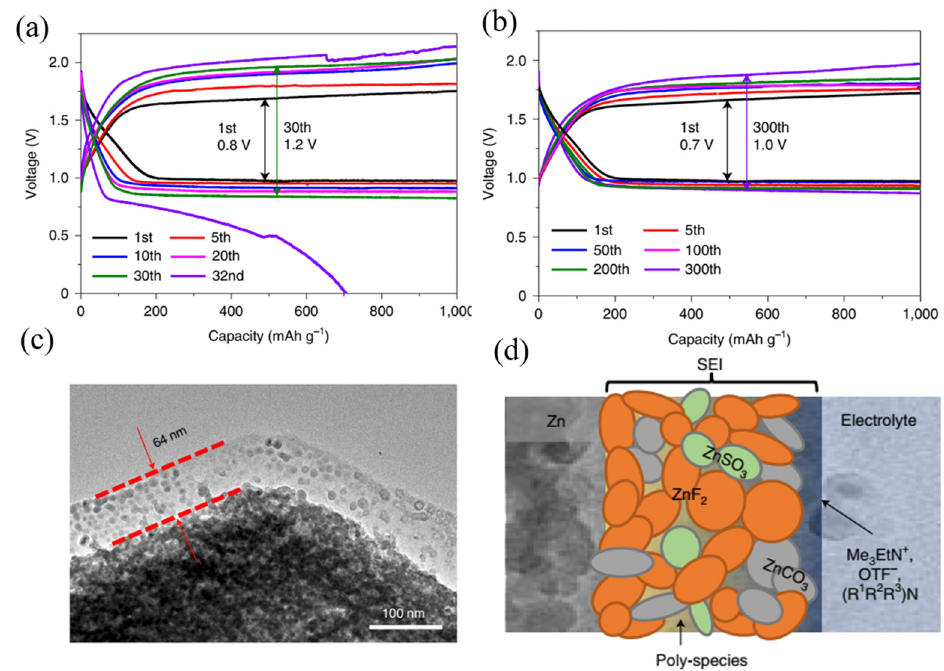
Figure 18. Cyclization profile of the zinc-O 2 batteries in the presence 4 m Zn(OTF) 2 ( a ) and 4 m Zn(OTF) 2 + 0.5 m Me 3 EtNOTF ( b ) chosen cycle number at 50 mA/g and below 1000 mA h/g (cathode areal capacity equals to 0.7 mAh/cm 2 ). TEM image of the zinc anode surface cycled in 4 m Zn(OTF) 2 + 0.5 m Me 3 EtNOTF ( c ), the red lines mark the width of the interphase. ( d ) Schematic of